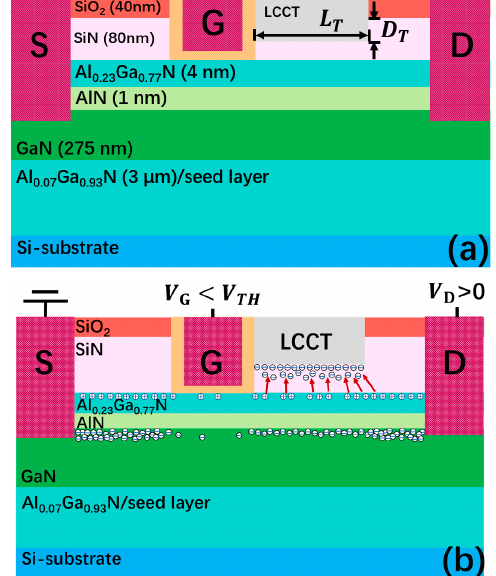
Figure 1. The schematic ( a ) cross-section of proposed high-electron-mobility transistor with a local charge compensation trench (LCCT-HEMT) and ( b ) illustration of local charge compensation (red arrow represents electric field